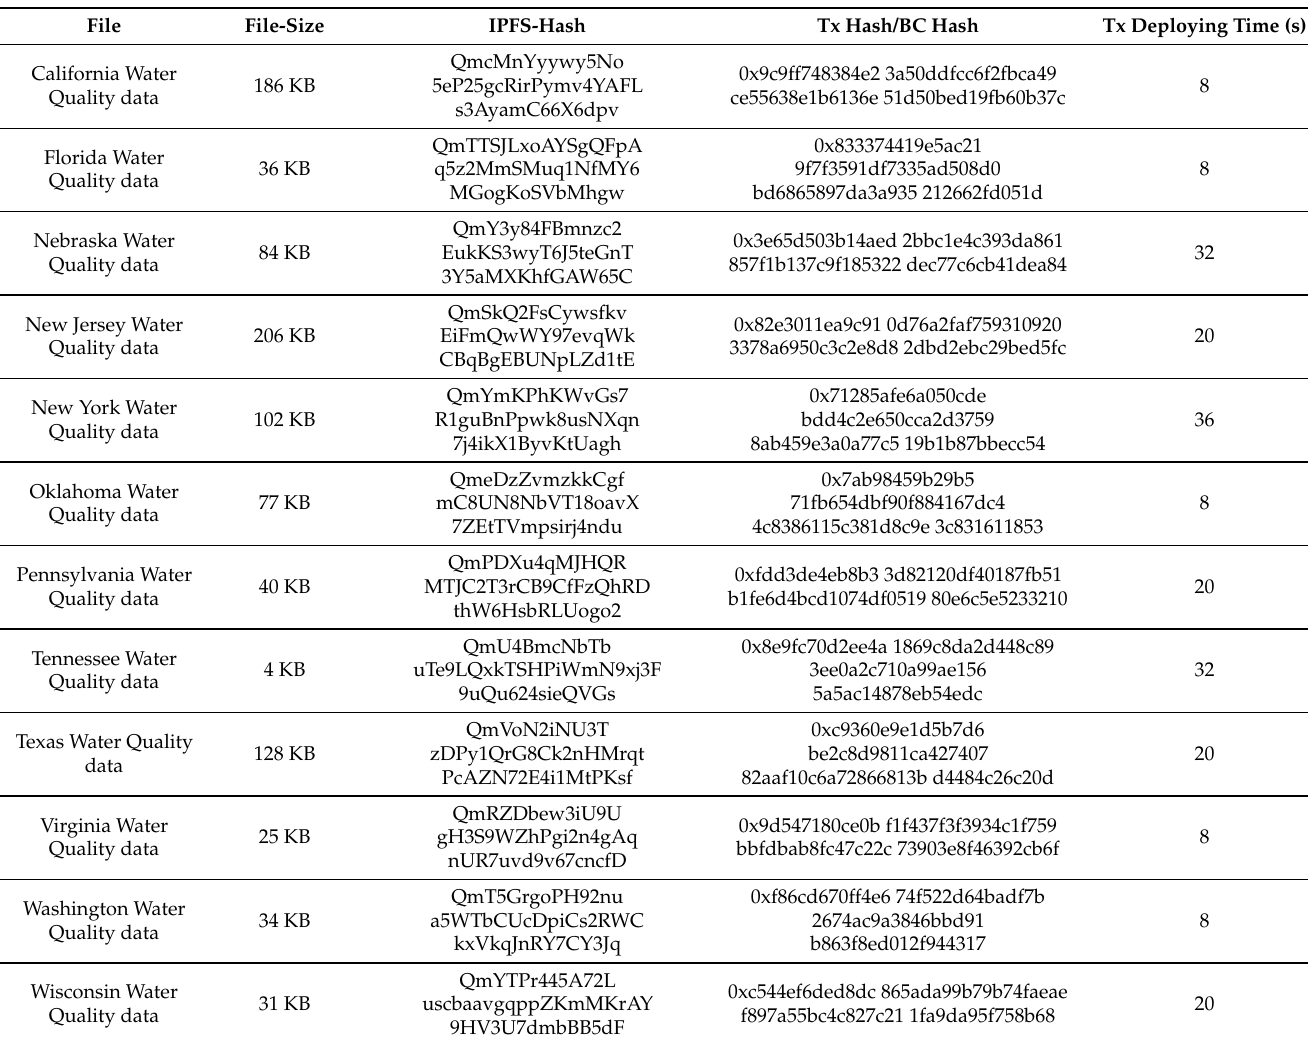
Table 3. Water quality Data sharing with double hash